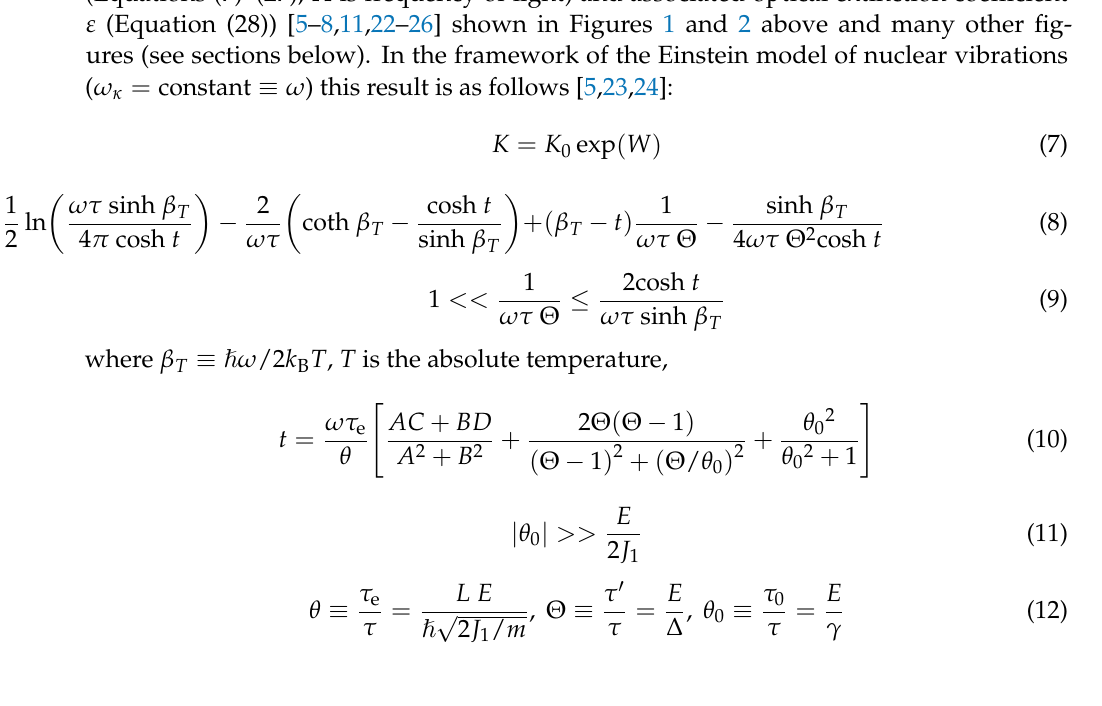
Figure 3. Alternation of positive (1) and negative (2) charges on carbon atoms along an ideal polymethine chain (IPS) in the ground state [8,38,39]. The distance between nitrogen atoms (N) is the length of the polymethine chain L . (Original citation)—Reproduced by permission of The Royal Society of Chemistry.